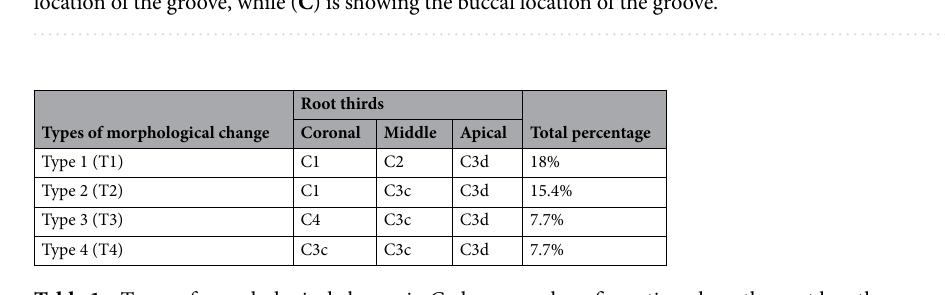
Table 1. Types of morphological change in C-shape canal configuration along the root